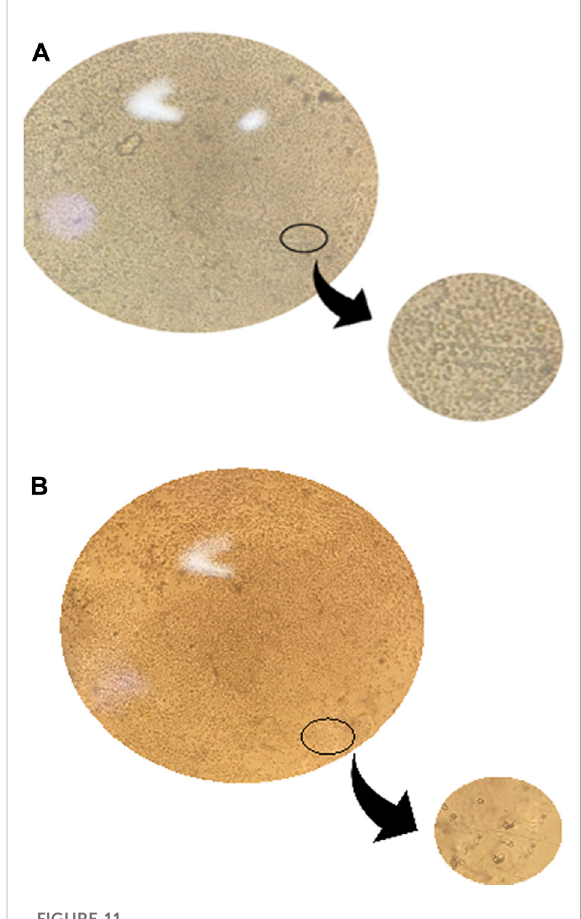
FIGURE 11 Morphology of CD14 + monocytes and TAMs of BC using a microscope. (A) Freshly isolated CD14 + monocyte ’ s morphology was examined using a microscope before differentiation. Examination showed cells with a spherical and smooth surface. The cells are considered small in size. (B) TAMs morphology was examined using the microscope on the 7th day after differentiation is completed, and examination showed cells morphology changed to be with an edgy and rough surface and a relatively larger size than